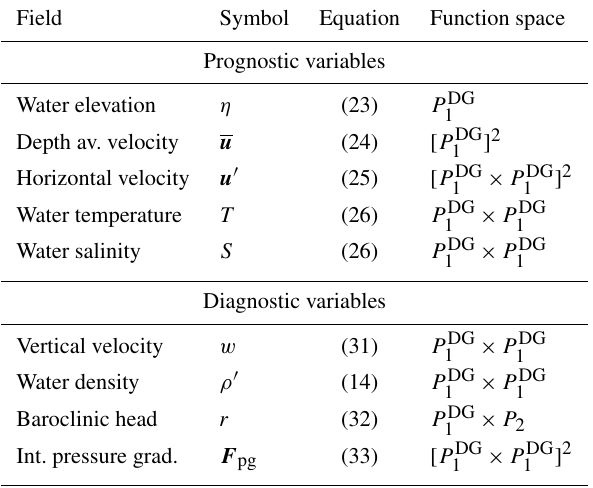
Table 1. Prognostic and diagnostic variables and their function